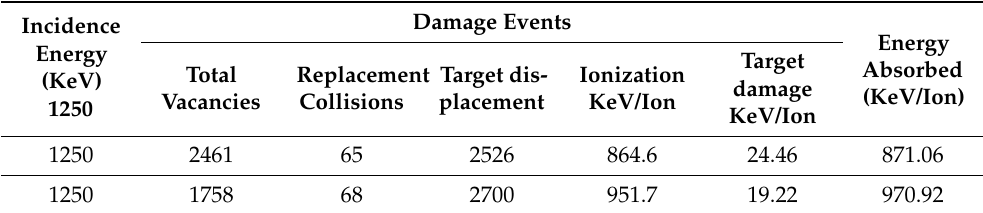
Table 3. The damage events and energy absorbed due to Cobalt-60 radiation source at 1250 KeV towards ZnO and MgZnO respectively.